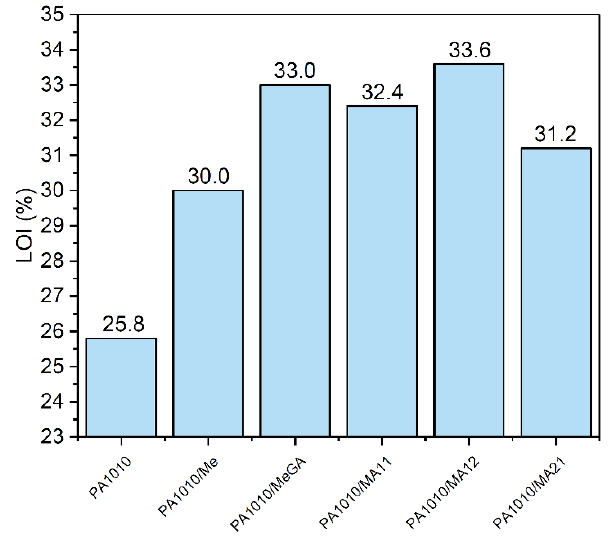
Figure 10. LOI values of PA1010 composites. Table 7. Results and classifications of the vertical burning measurements performed on PA1010 and its